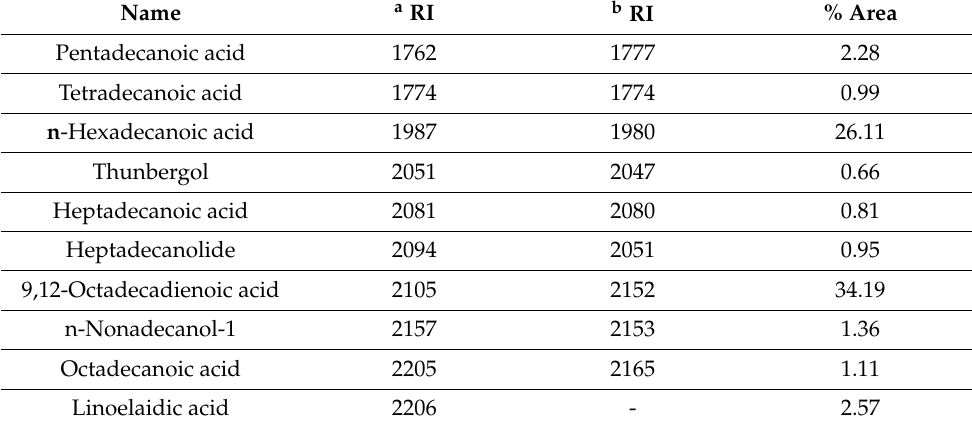
Table 1. Chemical composition of Taraxacum officinale essential oil.